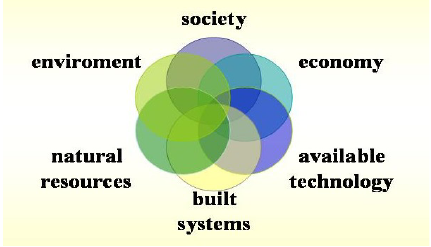
Fig 2. Modern approach to